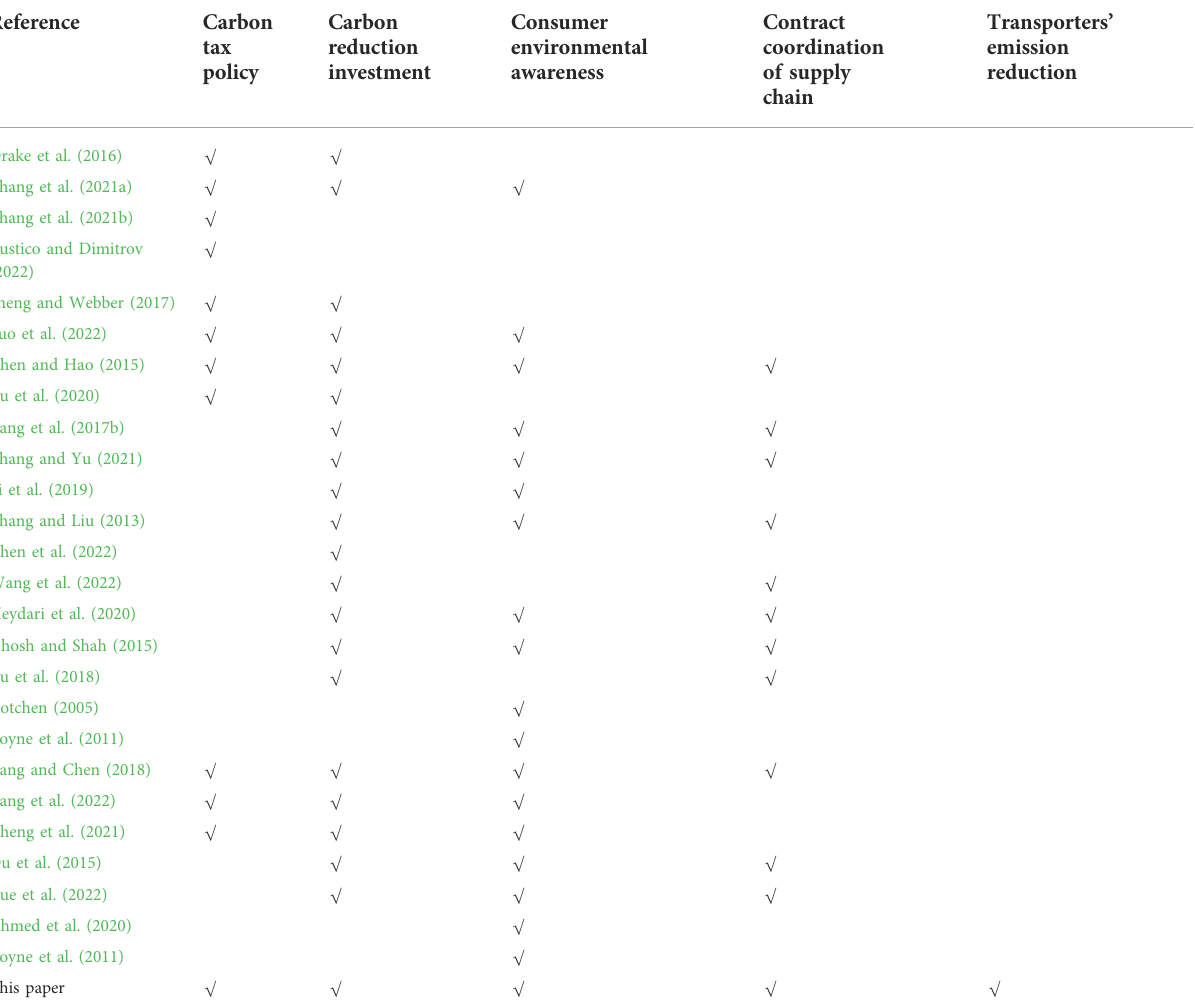
TABLE 1 Comparative study of relevant literature with this paper.